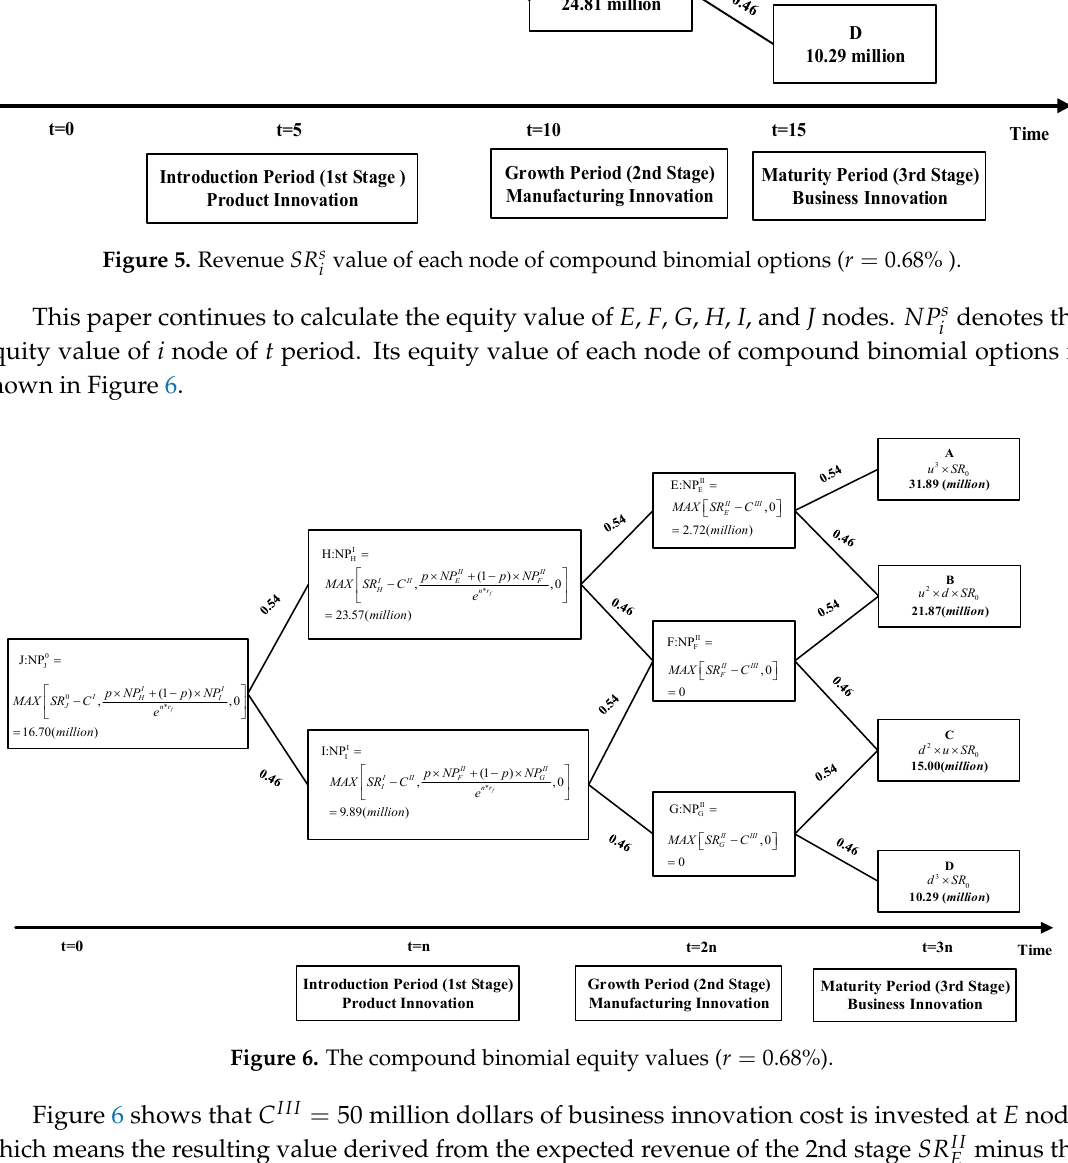
Figure 6. The compound binomial equity values ( 0.68% r ).